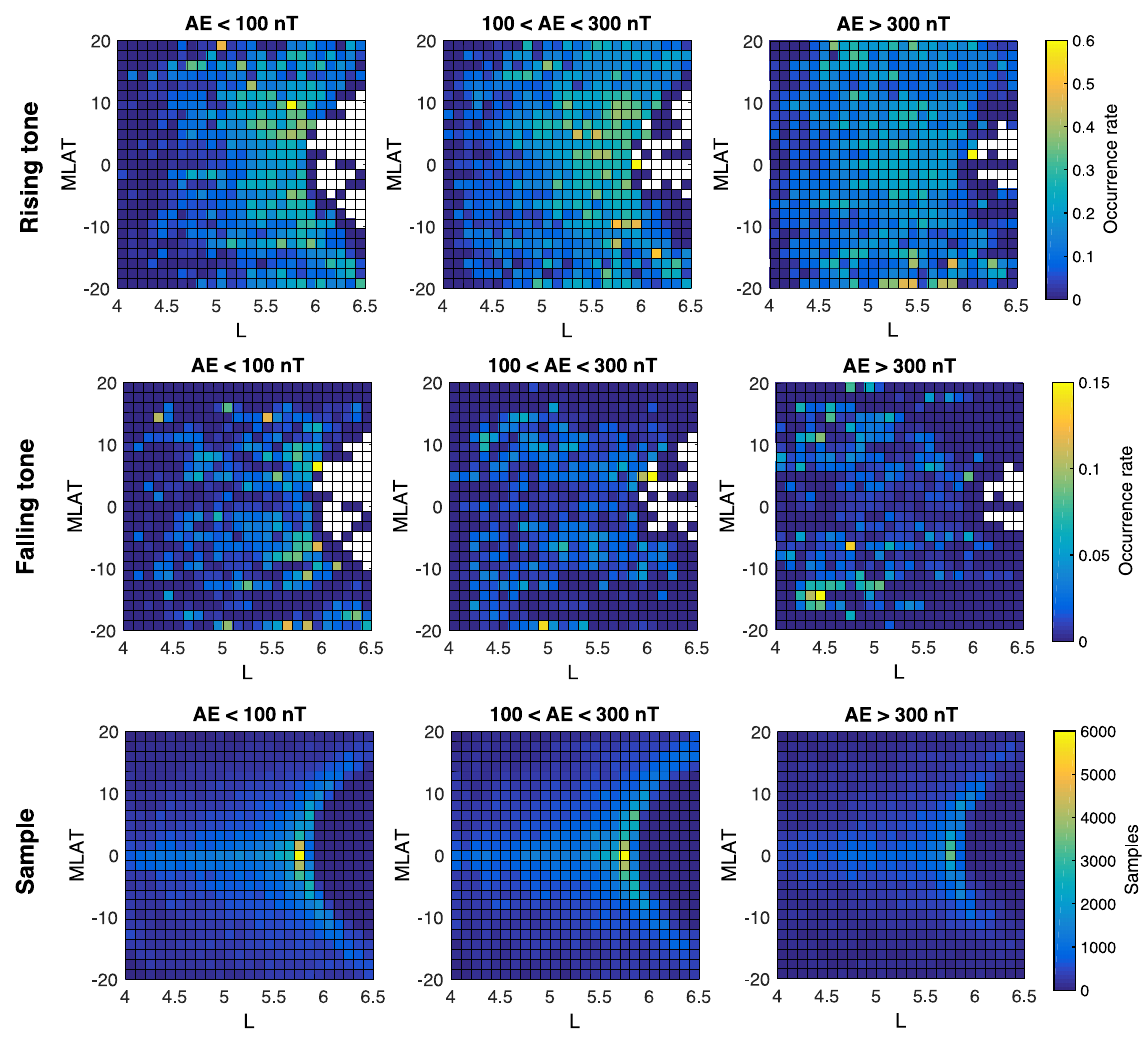
Figure 3. Similar to Fig. 2 but in MLAT– L